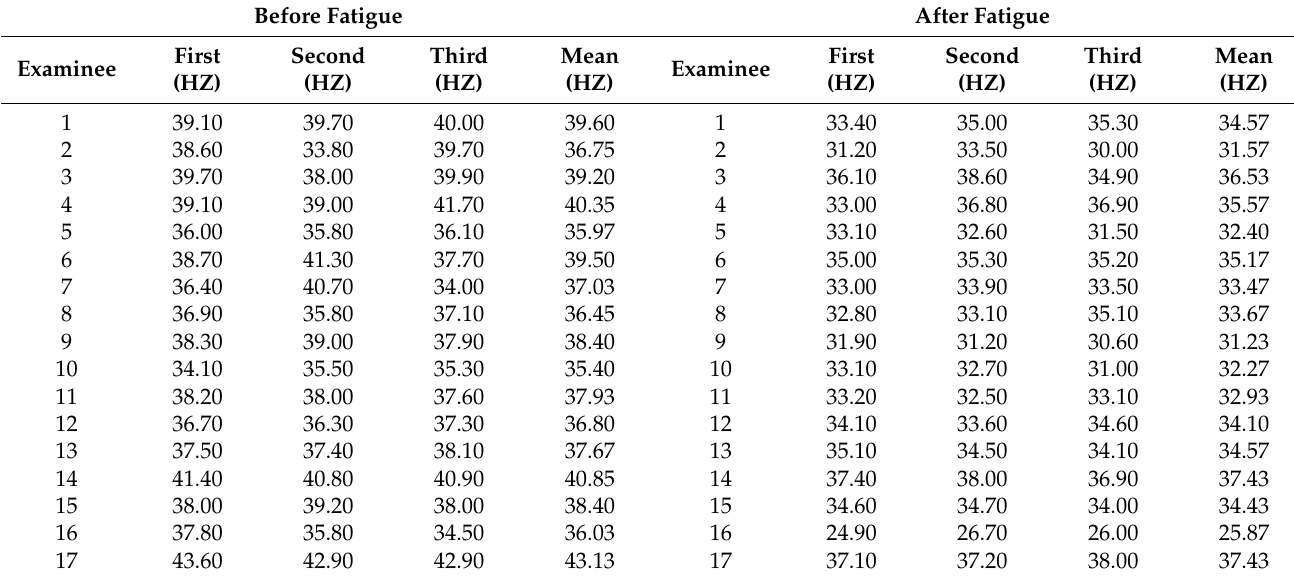
Table 7. Flicker fusion frequency values before and after brain